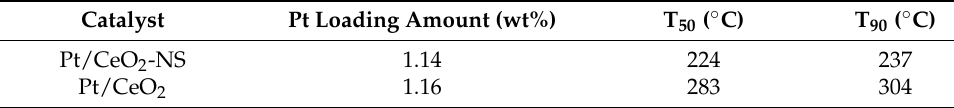
Figure 10. ( A ) Toluene catalytic combustion activity of Pt/CeO 2 -NS and Pt/CeO 2 ; ( B ) T 50 and T 90 of Pt/CeO 2 -NS and Pt/CeO 2 . Table 2. Pt loading amount, T 50 and T 90 of Pt/CeO 2 -NS and Pt/CeO 2 .